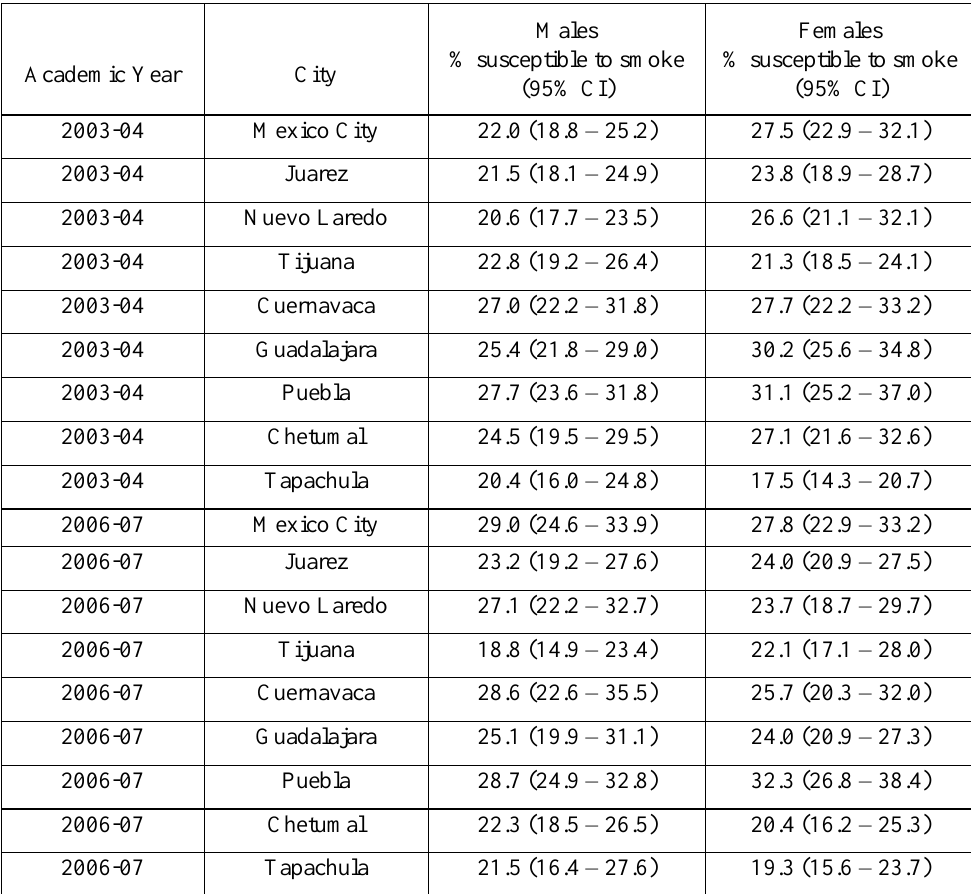
Table 3. Susceptibility to smoking among never smokers, by gender. GYTS Mexico 2003- 04 and 2006-07.